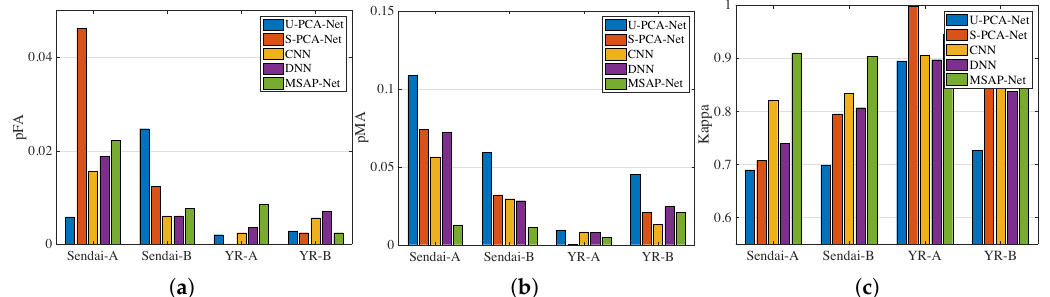
Figure 4. The comparisons of quantitative evaluations in terms of ( a ) false alarm (FA), ( b ) missed alarm (MA) and ( c ) Kappa coefficients.